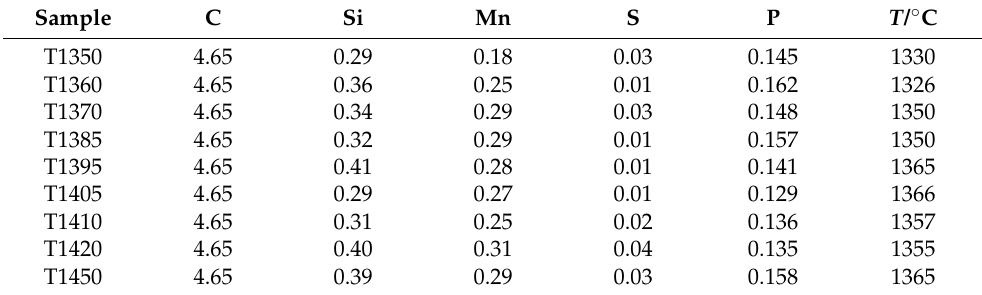
Table 1. The compositions and temperatures of the initial hot metal in converter